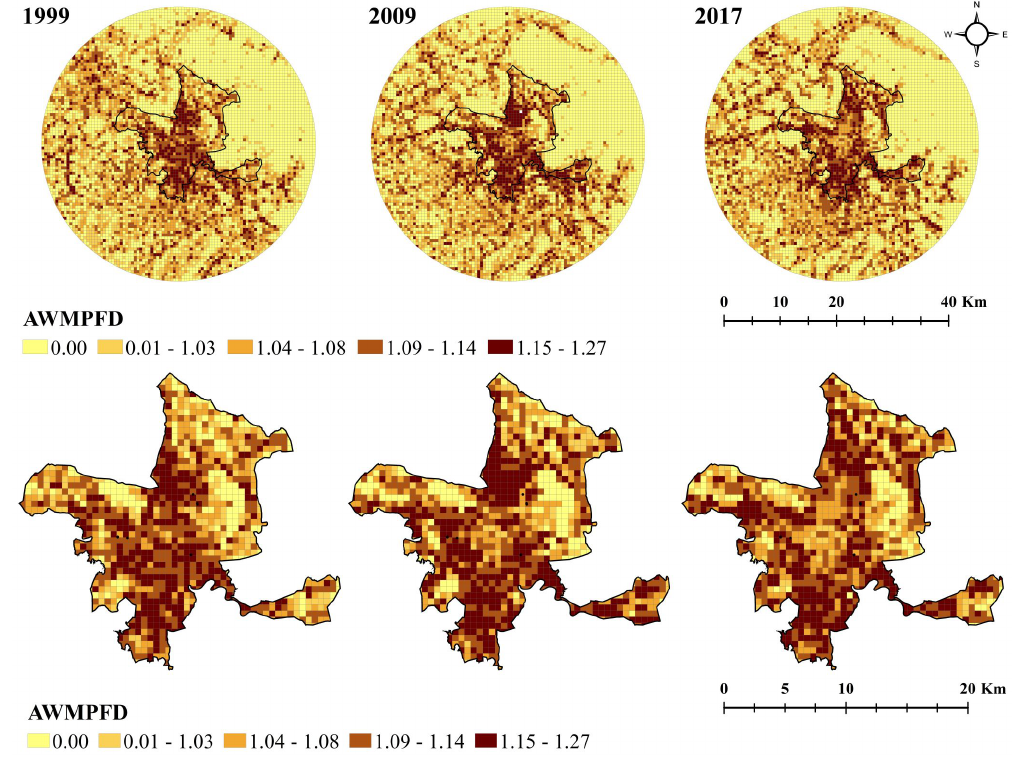
Figure 11. Area-weighted mean patch fractal dimension (AWMPFD) change at 500 m cell size with enlarged view of CA, year 1999, 2009 and 2017 in the study